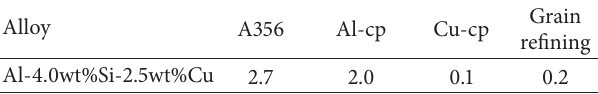
Table 1: Mass distribution for the preparation of alloy [in kg]. Alloy